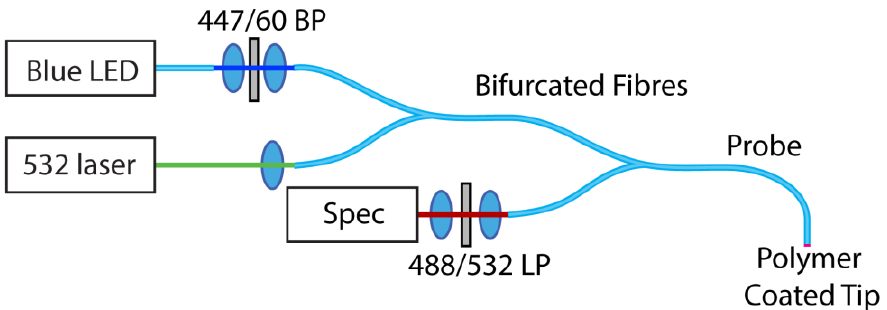
Figure 2. Experimental configuration for optical measurements of the combined pH/peroxide